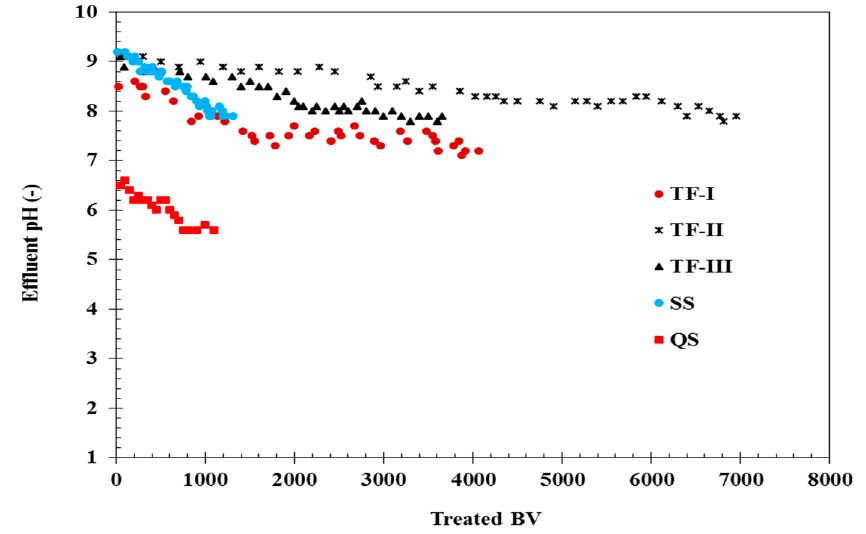
Figure 1. pH drift curves for column experiments conducted at influent pH value of 5.8 ± 0.2.